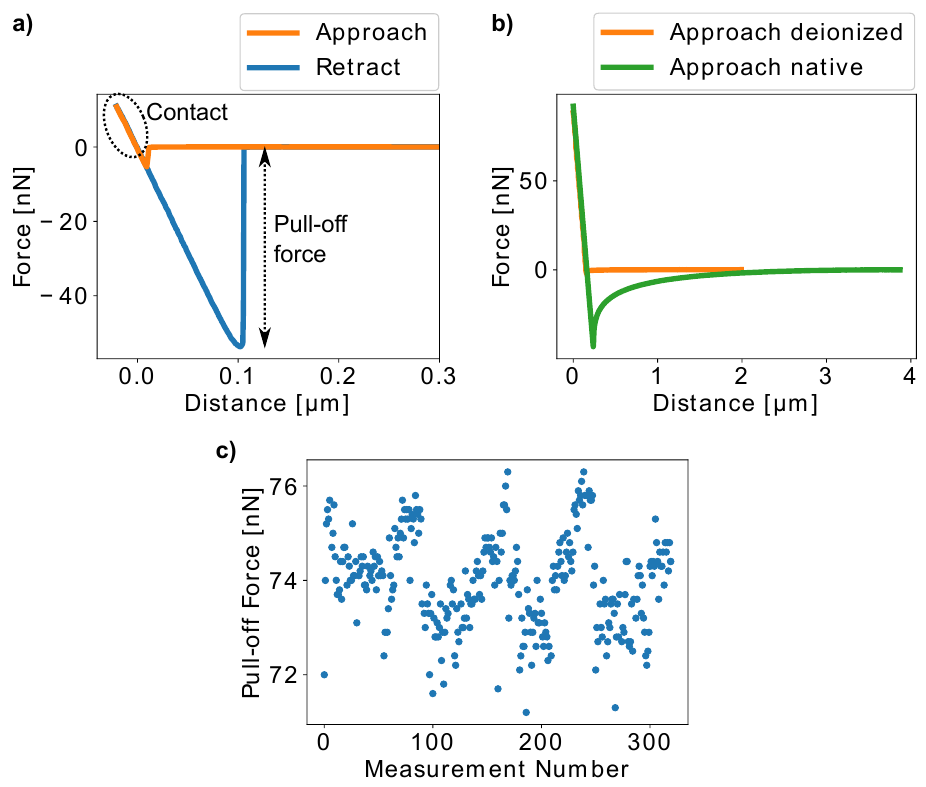
Figure 3. ( a ) An exemplary force–distance curve recorded with Hypochaeris radicata pollen on a glass slide. The curve’s linear behavior during the contact between pollen and glass indicates that the pollen was not deformed during the measurement, which ensures the repeatability of the experiment. The minimum of the retract part of the curve serves as a quantification of the adhesive forces between the pollen and the glass substrate (“pull-off force”). ( b ) The approach segments of force–distance curves before and after deionizing pollen and glass show that electrostatic interactions, which are sometimes present, can be removed from the setup using deionization. ( c ) 320 curves were recorded with one H. radicata pollen. The pull-off forces did not change significantly, showing that our experimental procedure is stable and